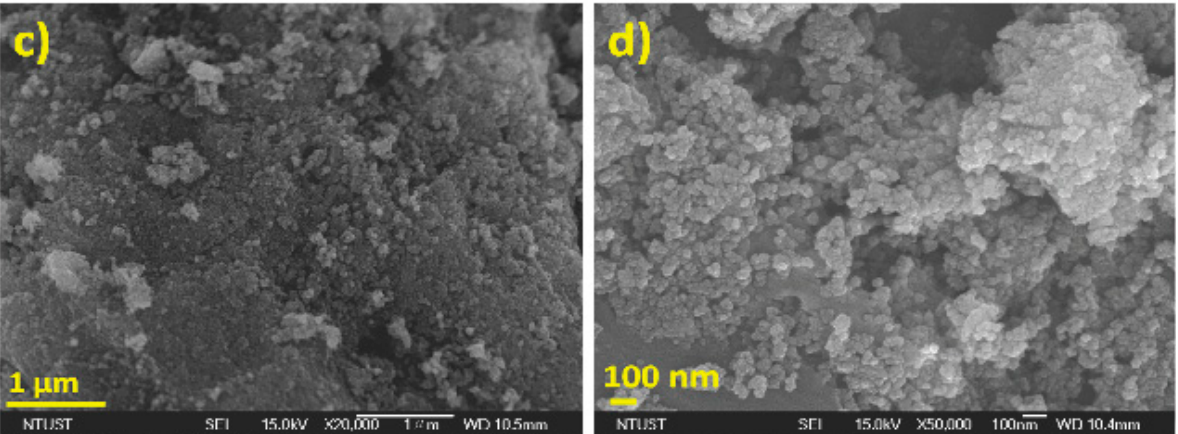
Figure 2. FE − SEM images of ( a ) CoFe 2 O 4 (Inset shows TEM image), ( b ) SWPS, ( c ) SWPS/MNp (10 wt%) and ( d ) SWPS/MNp (20 wt%).